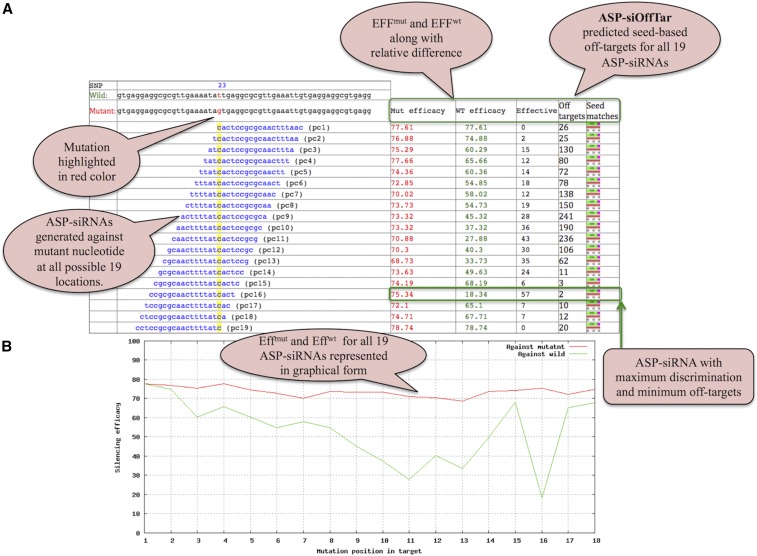
Description of ASPsiPred web server with result output. (A) Screenshot demonstrating ASP-siRNAs generated against a T > G mutation at all possible 19 positions along with Effmut and Effwild predicted from ASPsiPredSVM and ASPsiPredmatrix, respectively. Their relative difference between the two efficacies is also displayed along with the prediction of seed-based off-targets for all 19 ASP-siRNAs. (B) The output of the Effmut and Effwild of 19 ASP-siRNAs in graphical form.